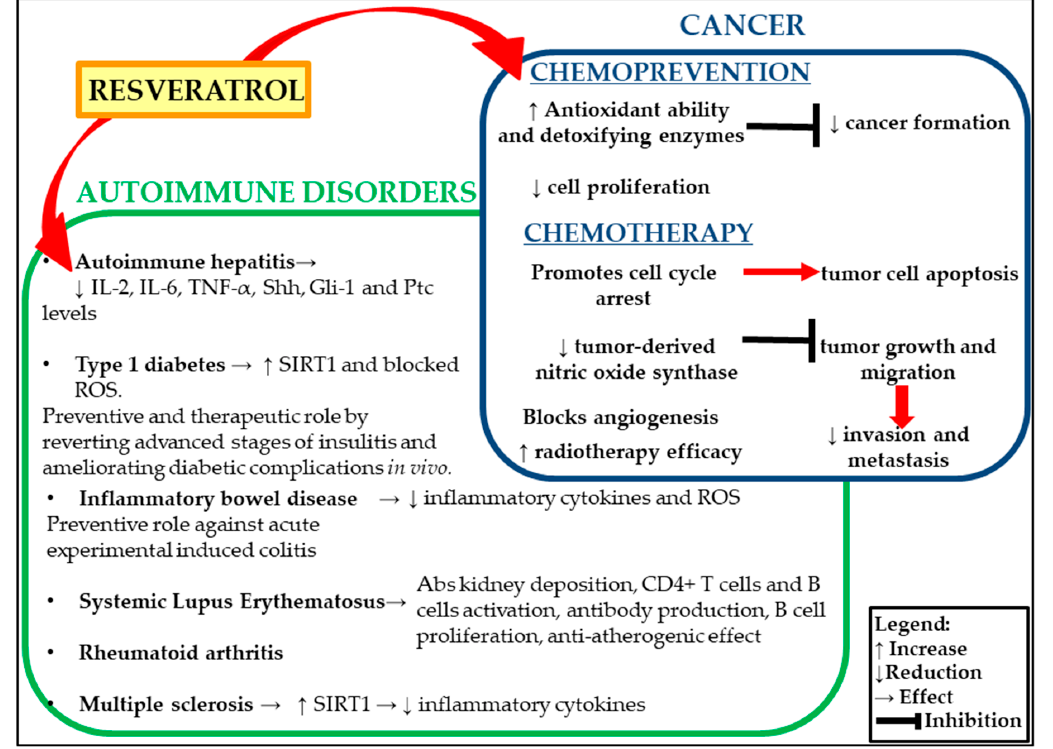
Figure 1. Dual role of resveratrol on autoimmune disorders and cancer.